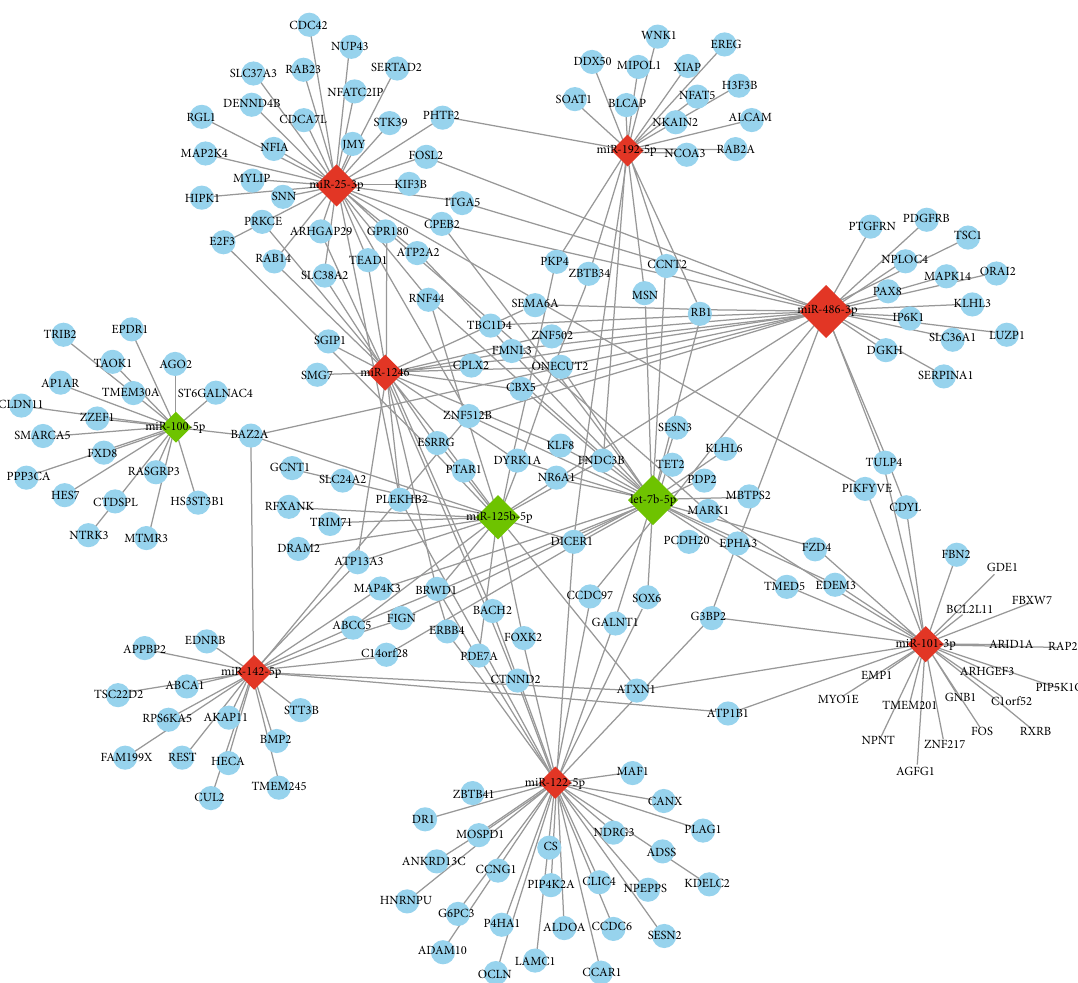
Figure 8: miRNA-mRNA network. The relationship between di ff erentially expressed miRNAs and their target